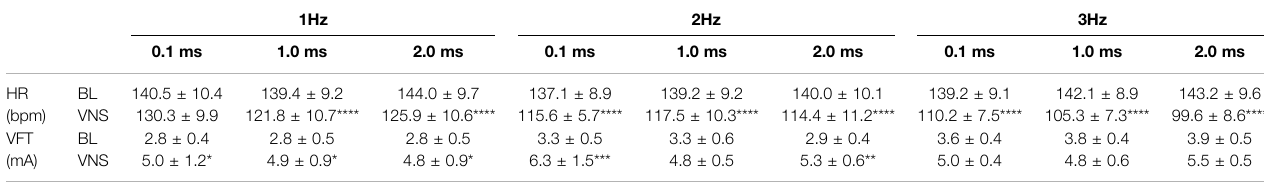
TABLE1| TheeffectsofhighvoltageandlowfrequencyVNSonHRandVFT.HRchangesfrombaseline(BL)toVNSat1(A),2(B)and3 Hz(C)atstimulationpulsewidthsof 0.1,1and2 ms.VFTchangesfrombaseline(BL)toVNSat1(D),2(E)and3 Hz(F)atstimulationpulsewidthsof0.1,1,and2 ms.Datarepresentmean±SEM.* p <